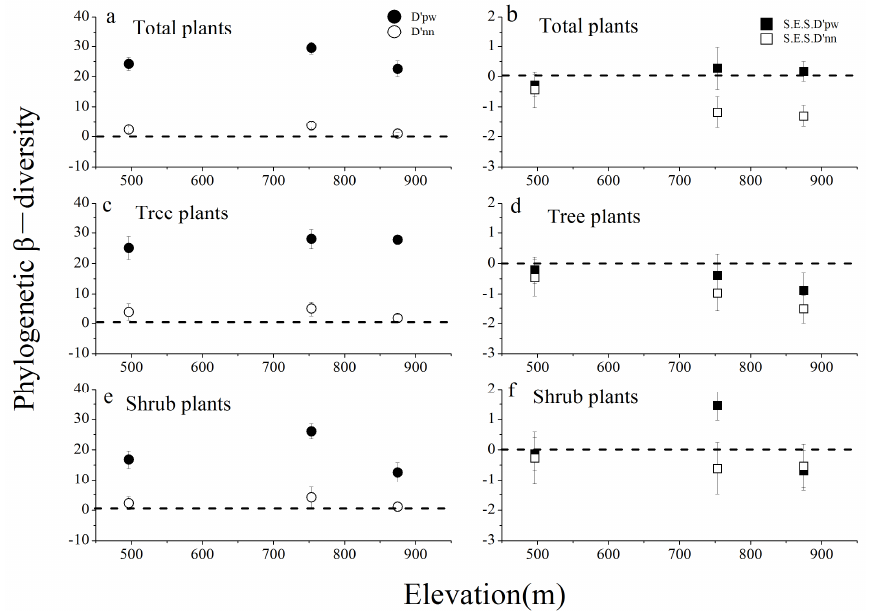
Figure 4. The patterns of phylogenetic β diversity were assessed by computing the mean pairwise phylogenetic distance (D’pw) and the nearest neighbor distance (D’nn) for total plants ( a ), trees ( c ), and shrubs ( e ). The change in standardized mean pairwise phylogenetic distance (S.E.S.D’pw) and the nearest neighbor distance (S.E.S.D’nn) of phylogenetic β -diversity for total plants ( b ), trees ( d ), and shrubs ( f ). Table 3. Variation in phylogenetic β -diversity was analyzed in relation to spatial, climatic, and topographic factors for total plants, trees, and shrubs using the multiple regression on distance matrix (MRM)